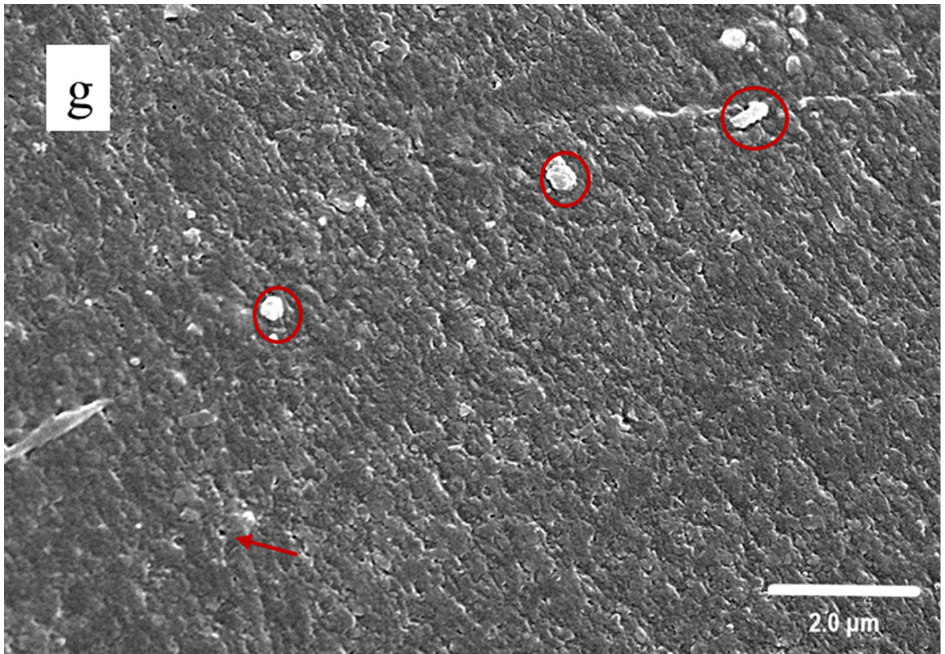
Figure 4. SEM Images of the surface of the pulp and regenerated cellulose fibers: Pulp ( a ), BF ( b ), UF ( c ), GF ( d ), CCF ( e ), CCUF ( f ), and CCGF ( g ). The irregular pores and cracks (marked by arrows), and the protrusions (marked by cycles) are given in red highlight.